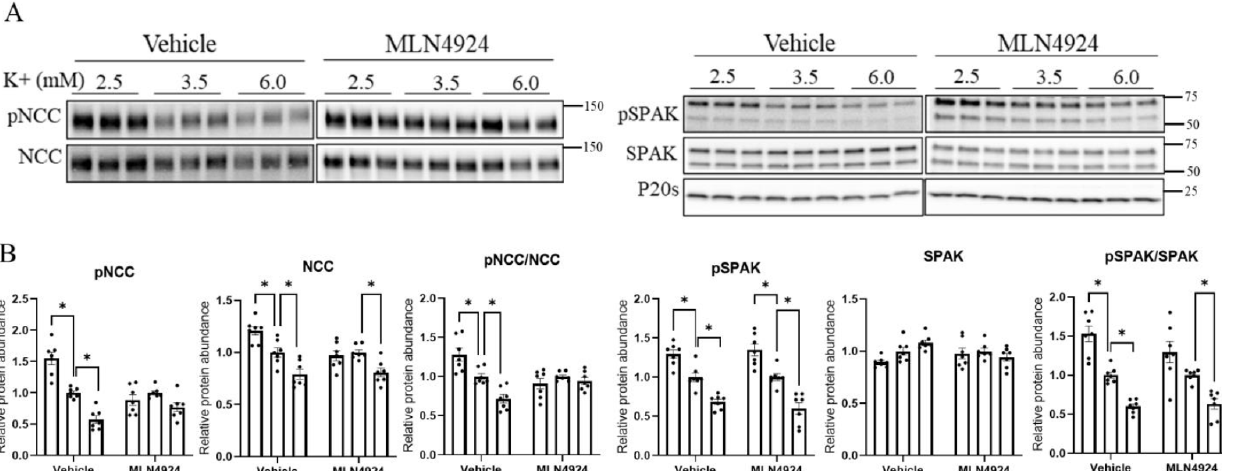
Figure 7. Short-term increase in NCC phosphorylation in response to lower extracellular K + is absent in the presence of MLN4924 in isolated renal tubules ex vivo. ( A ) Representative immunoblots of pNCC, NCC, pSPAK, SPAK, and P20s in isolated renal tubules that were incubated in the media containing different K + concentrations (2.5, 3.5, or 6 mM K + ) in the presence of either the vehicle or cullin inhibitor (MLN4924; 0.5 uM) for 30 min ex vivo. Molecular weight markers (kDa) are shown on the right. ( B ) Summarized relative protein abundance data. Each dot represents value from an individual well of independent tubules and each bar represents mean ± SEM obtained from two independent experiments ( n = 8). * indicates p < 0.05 relative to the 3.5 mM K + group.